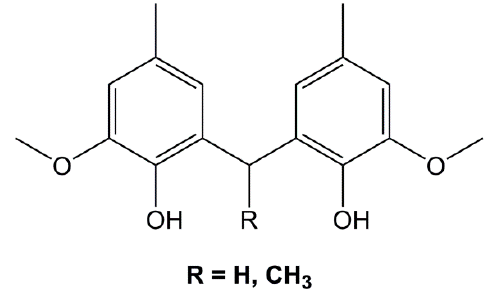
Figure 20. Creosol-based di-phenolic derivative synthesized by Meylemans et al. [160].